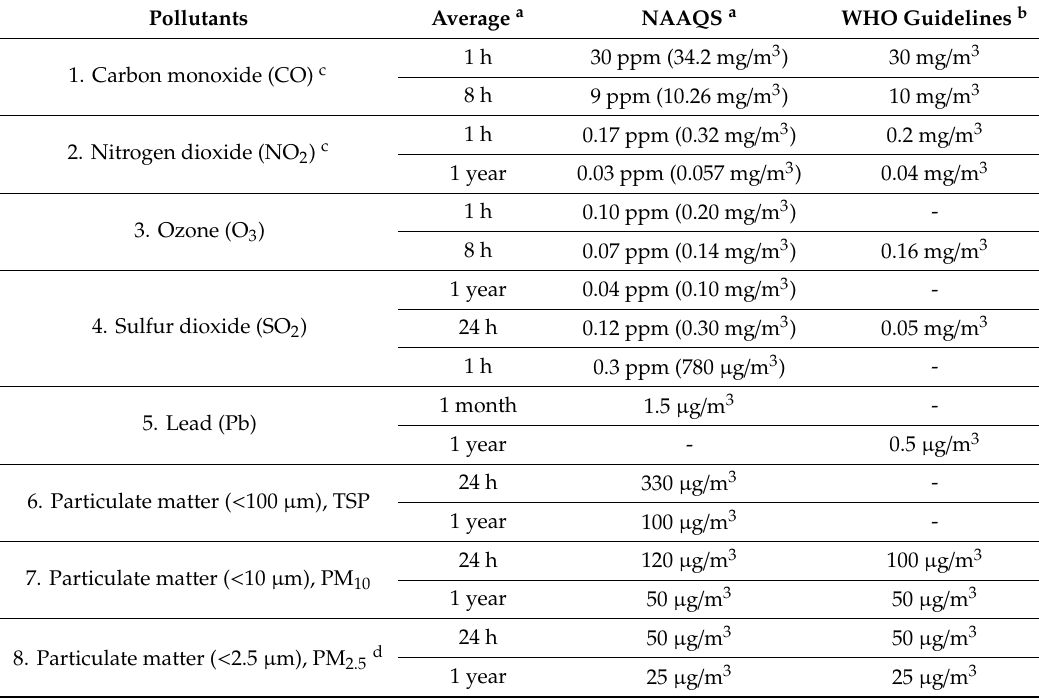
Table A1. Comparison of Thailand’s NAAQS with WHO’s